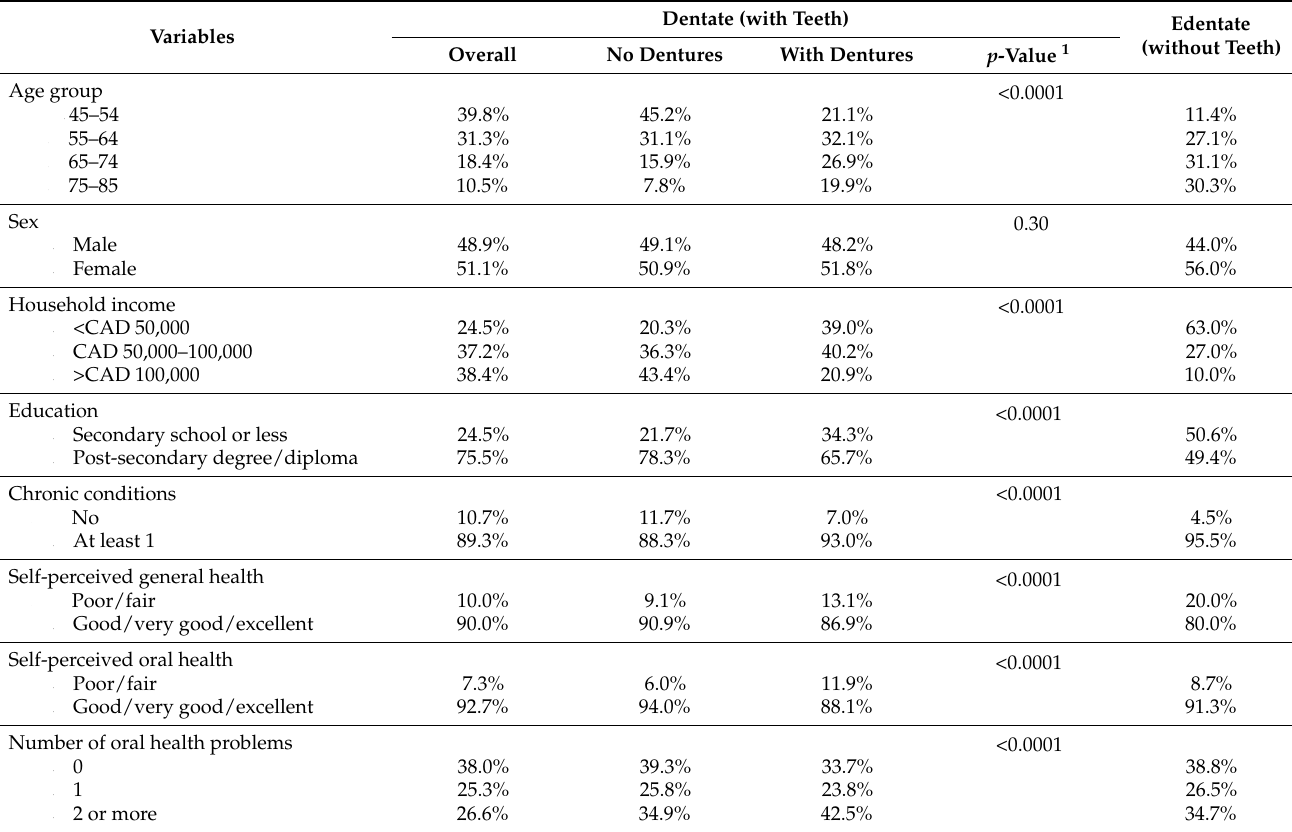
Table 1. Characteristics of Canadian adults from the Canadian Longitudinal Study on Aging at base- Table 2. Percentage of oral health problems among males and females from the Canadian Longitudinal Study on Aging (CLSA) at CLSA baseline (2011-2015), by teeth status. line (2011–2015), by teeth status. Table 2. Percentage of oral health problems among males and females from the Canadian Longitudinal Study on Aging (CLSA) at CLSA baseline (2011-2015), by teeth status. Table 2. Percentage of oral health problems among males and females from the Canadian Longitudinal Study on Aging (CLSA) at CLSA baseline (2011-2015), by teeth status. Table 2. Percentage of oral health problems among males and females from the Canadian Longitudinal Study on Aging (CLSA) at CLSA baseline (2011-2015), by teeth status. Table 2. Percentage of oral health problems among males and females from the Canadian Longitudinal Study on Aging (CLSA) at CLSA baseline (2011-2015), by teeth status. Table 2. Percentage of oral health problems among males and females from the Canadian Longitudinal Study on Aging (CLSA) at CLSA baseline (2011-2015), by teeth Oral Health Problems